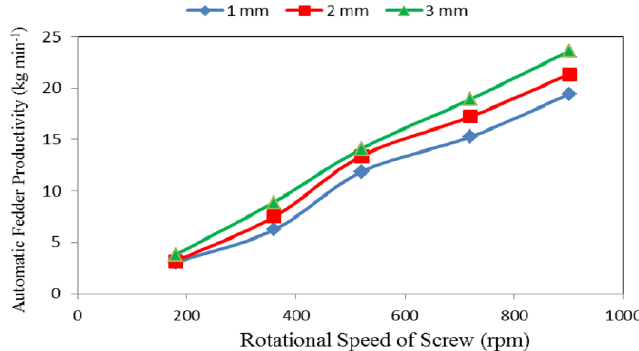
Figure 4. Automatic feeder productivity at different feed pellet sizes and rotational speeds of